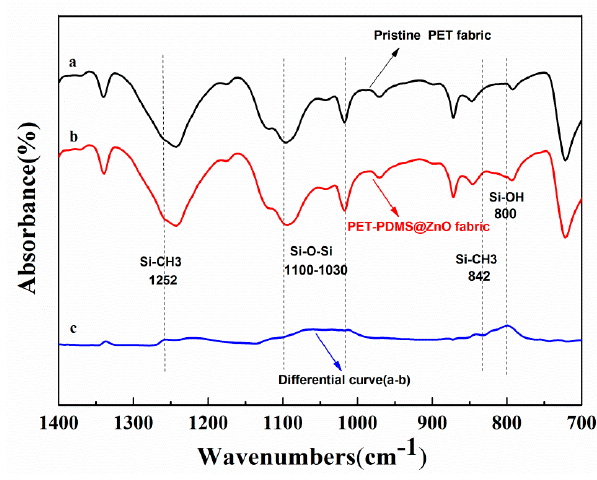
Figure 3. FTIR spectra of samples.